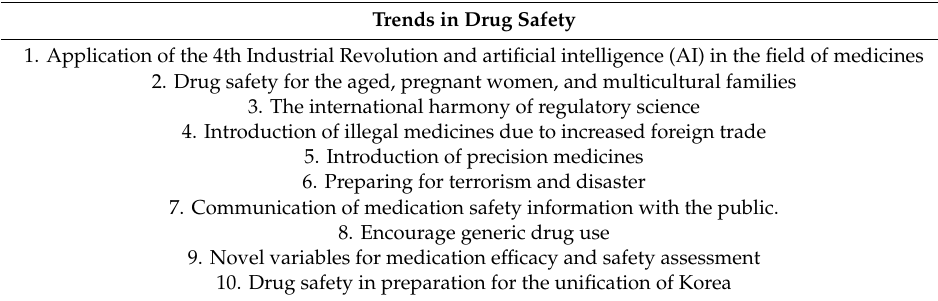
Table 1. Ten trends in safety management of medicines.